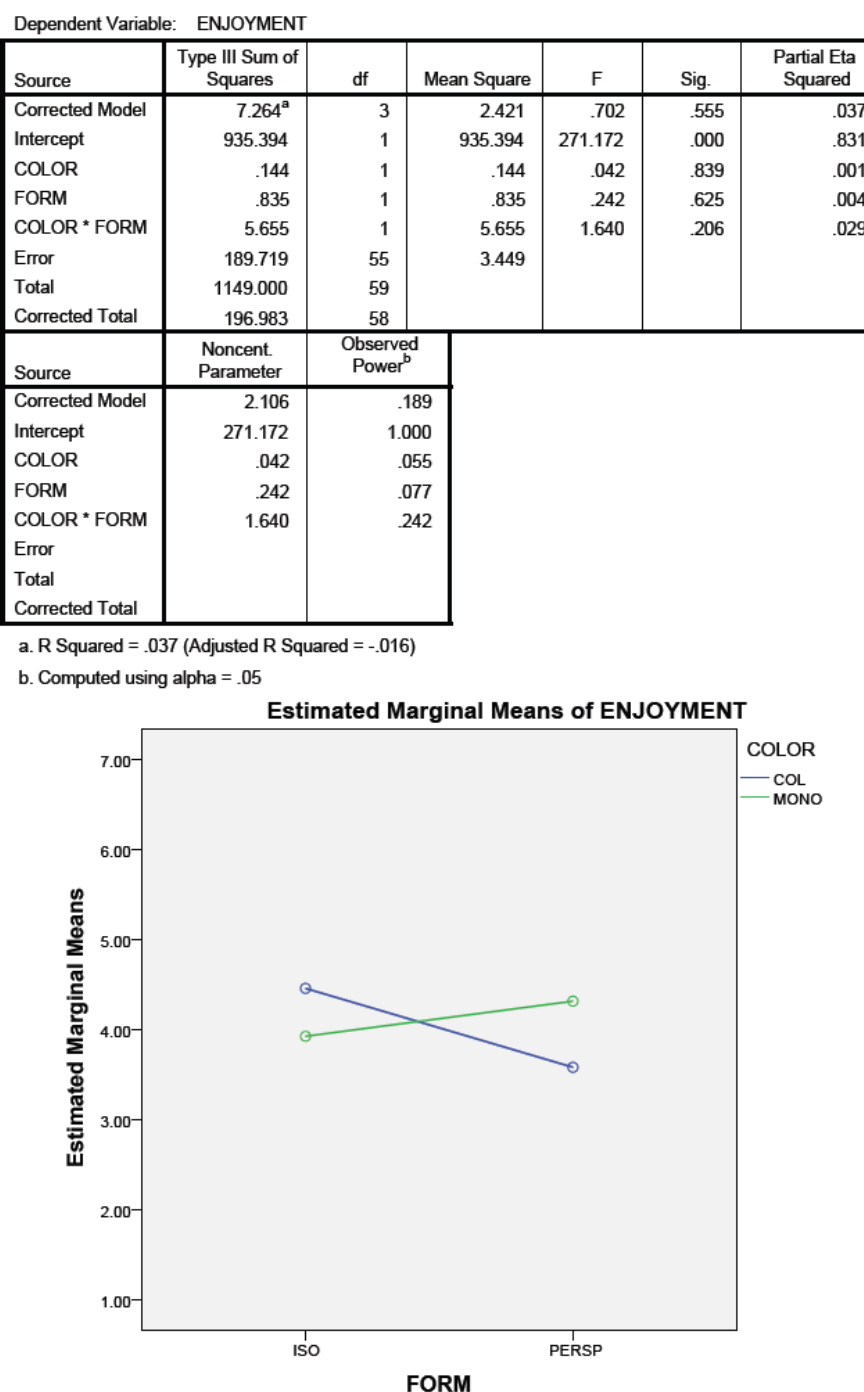
Figure B.19. ANOVA analysing enjoyment levels for the main and interaction effects of color and form using raw data for participants who correctly indicated their